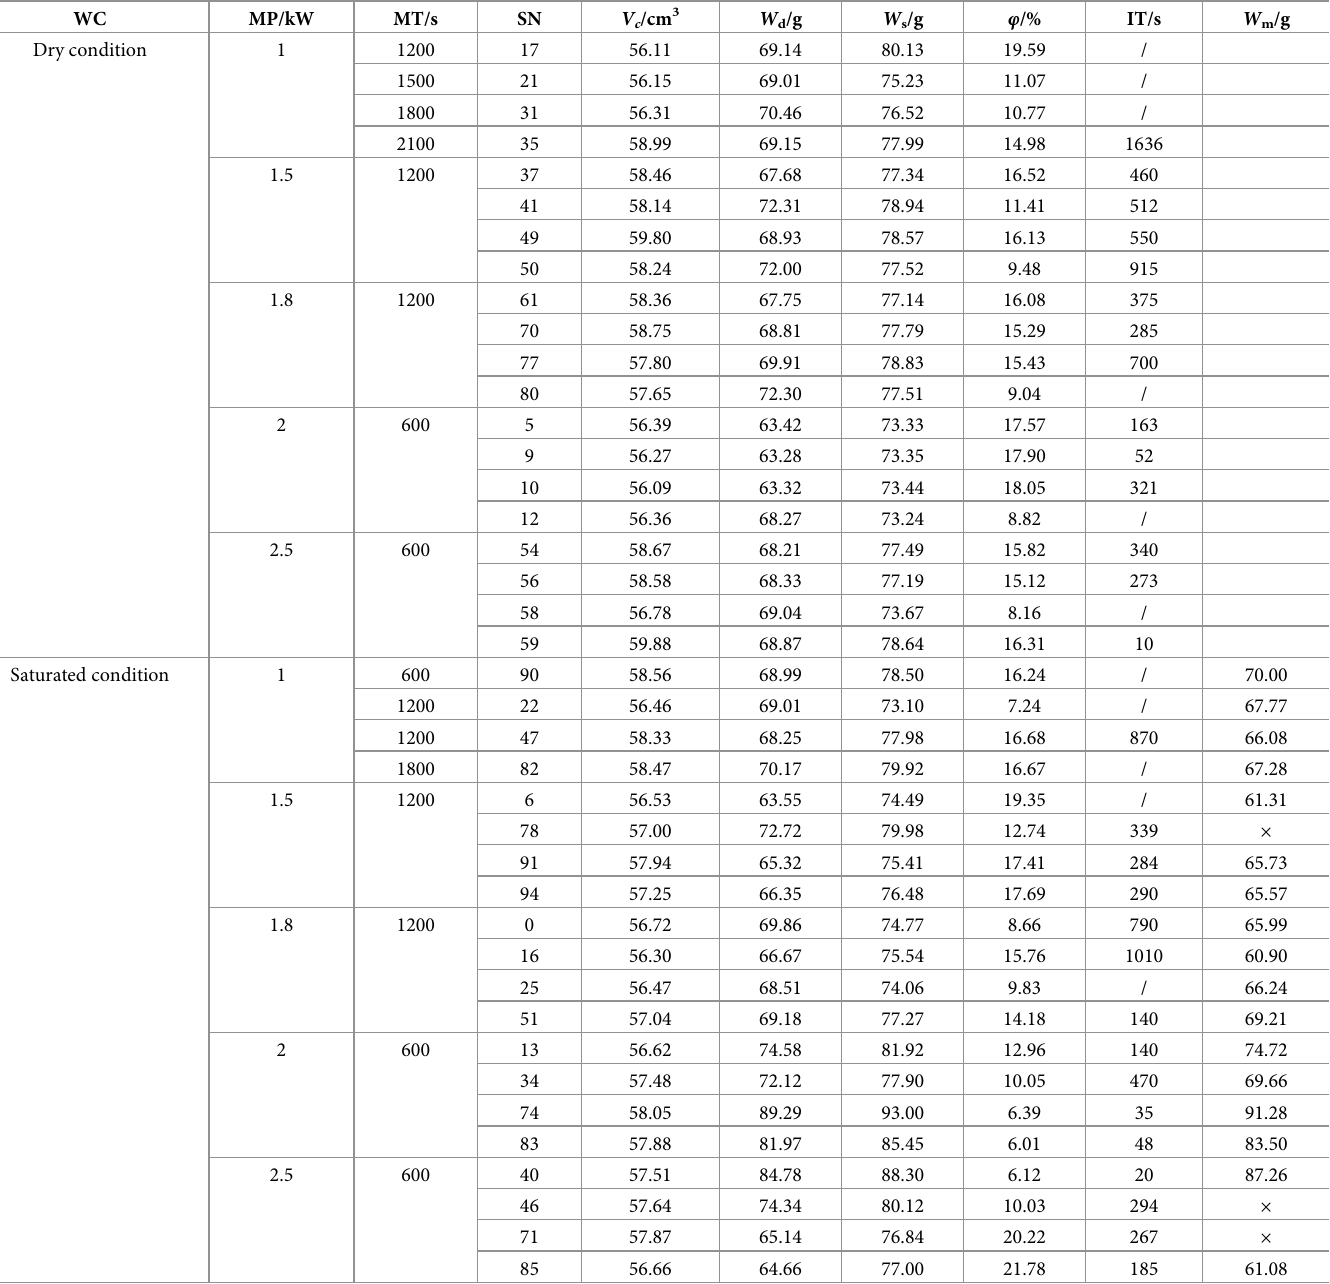
Table 1. Basic experimental data. WC